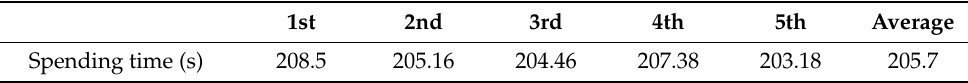
Figure 12. Performance test of the prototype in a curved pipe. ( a ) the start and ( b ) the turning. Table 3. Time of 200 mm movement.